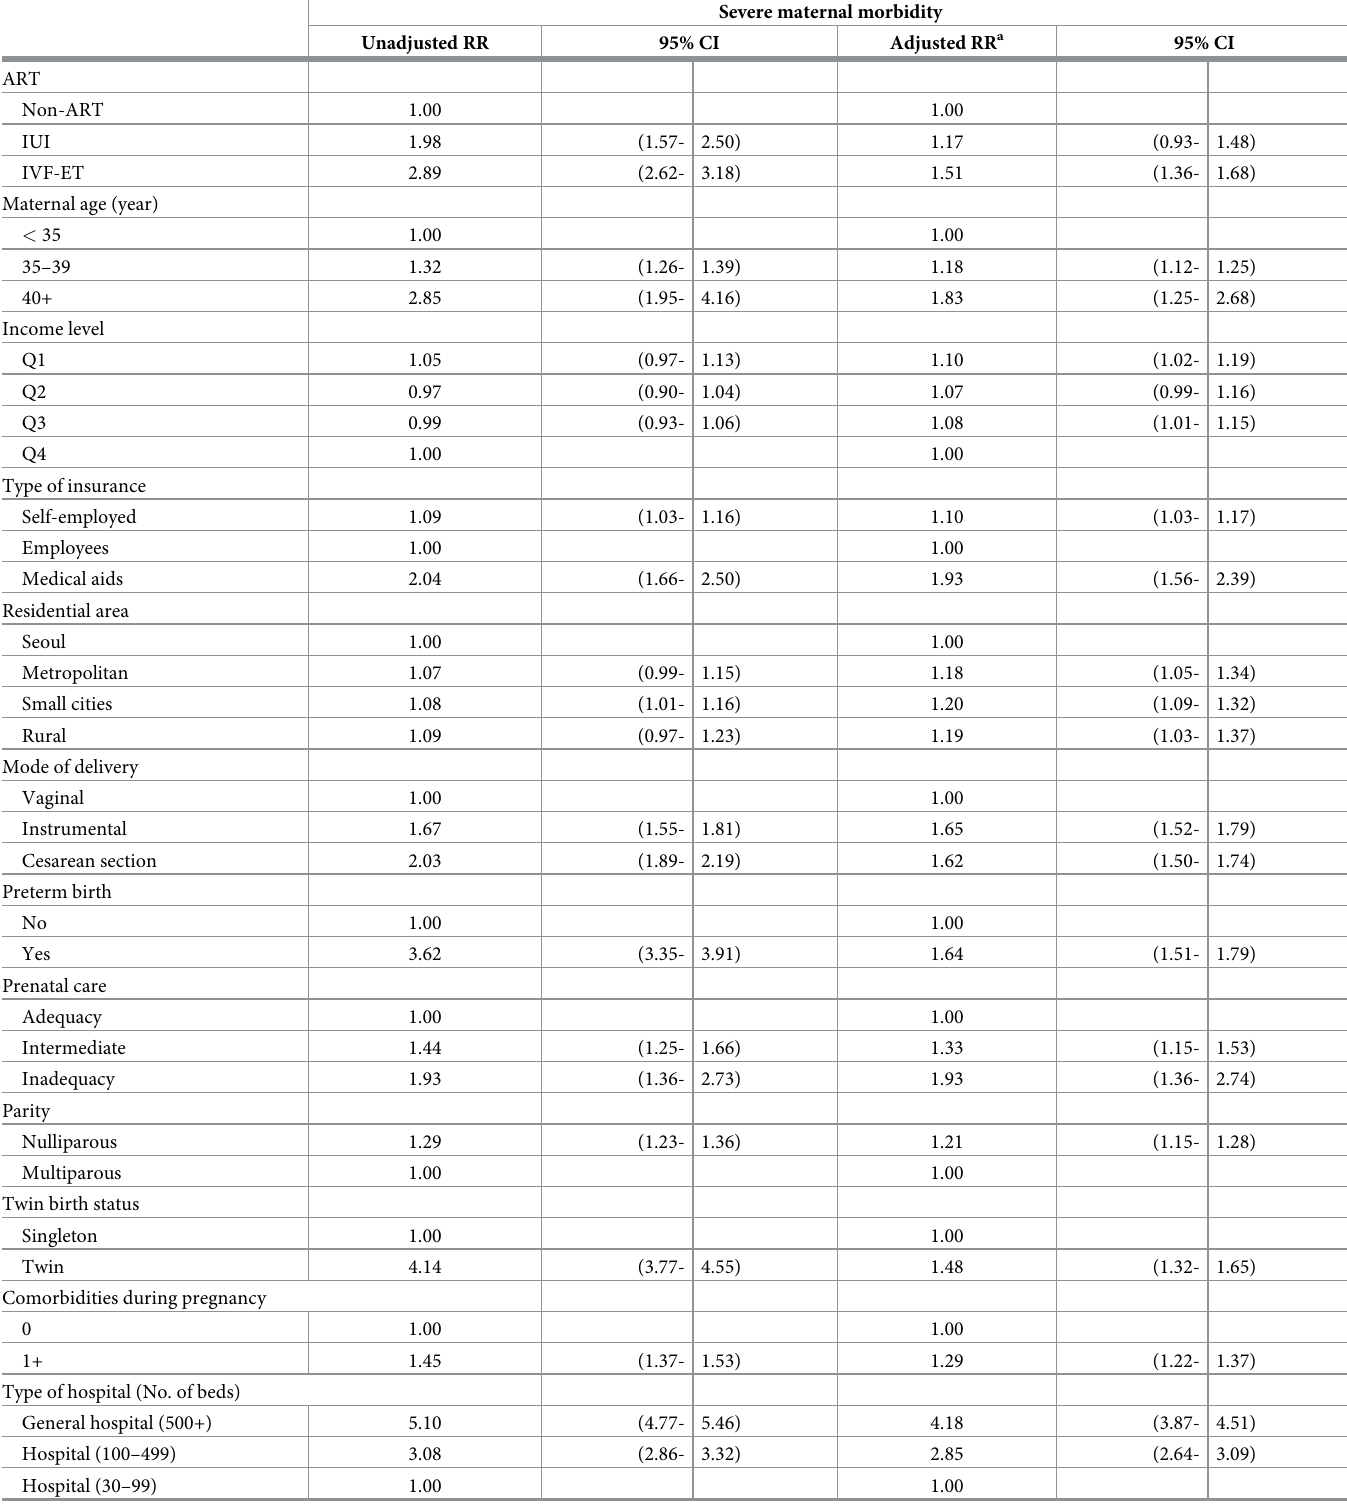
Table 2. Association between assisted reproductive technology and severe maternal morbidity, using unadjusted and adjusted models for all